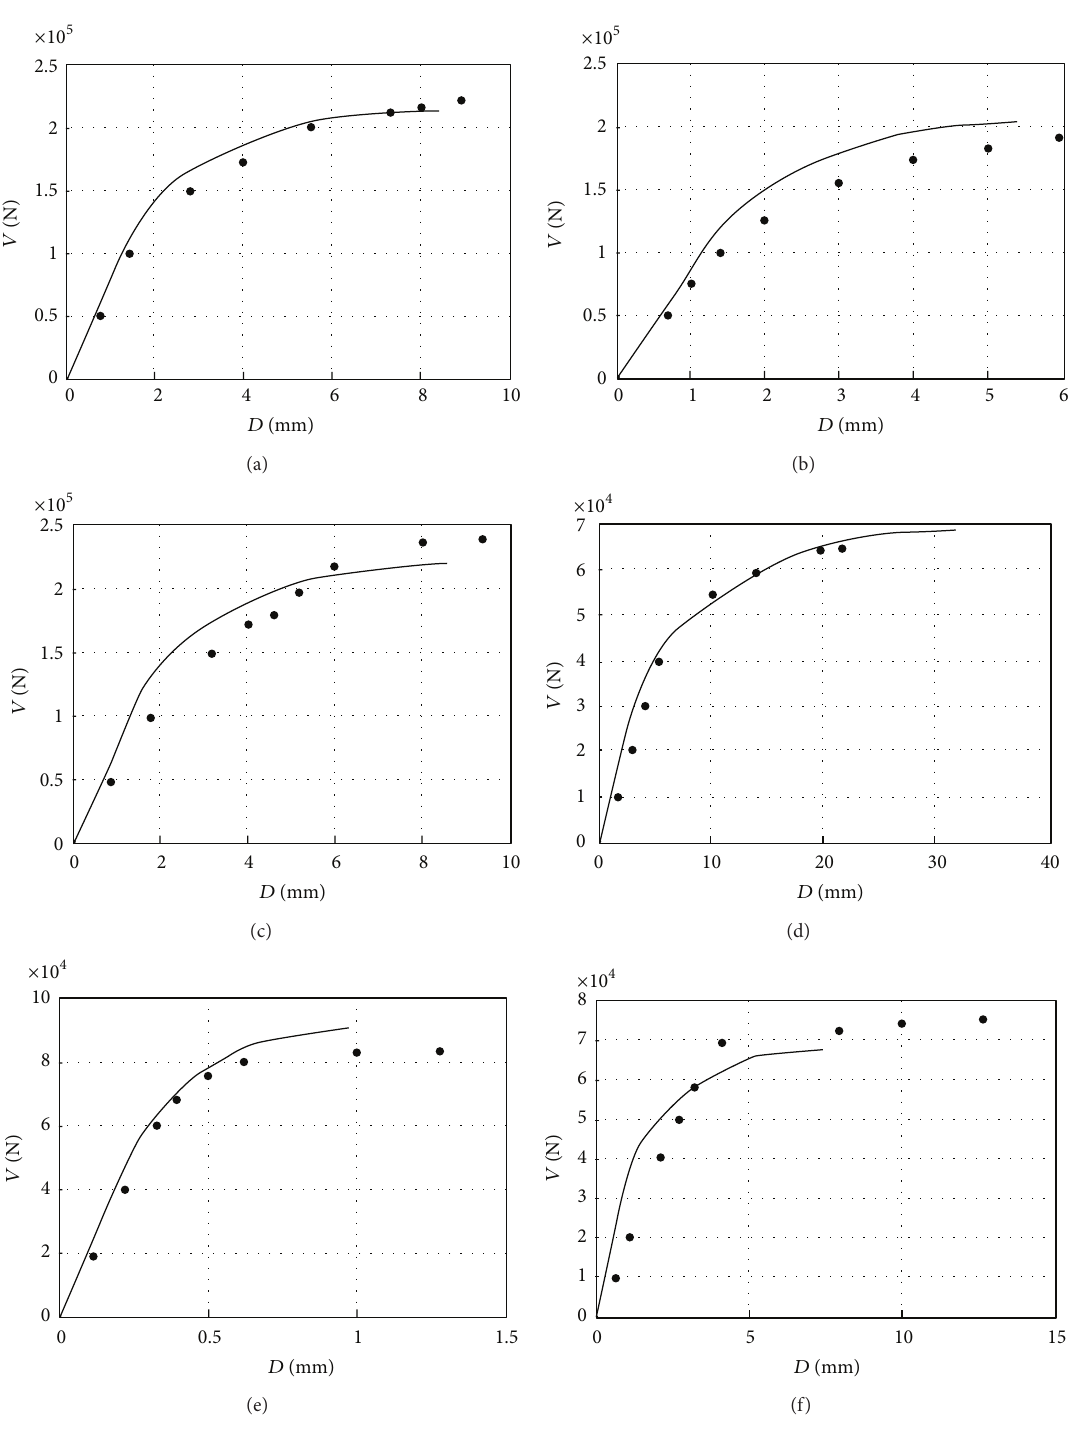
Figure 8: Comparisons between numerical and experimental capacity curves of unstrengthened